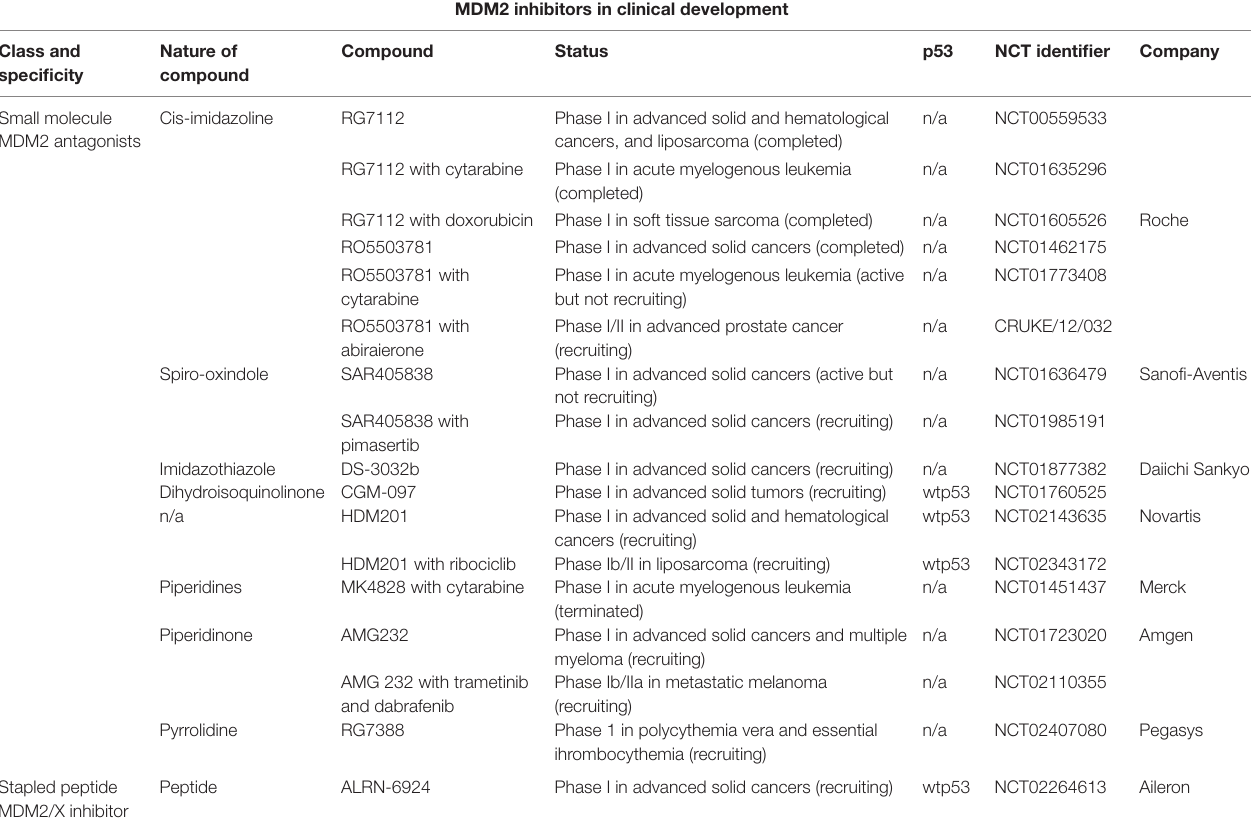
TABLe 1 | MDM2 and MDMX inhibitors in clinical